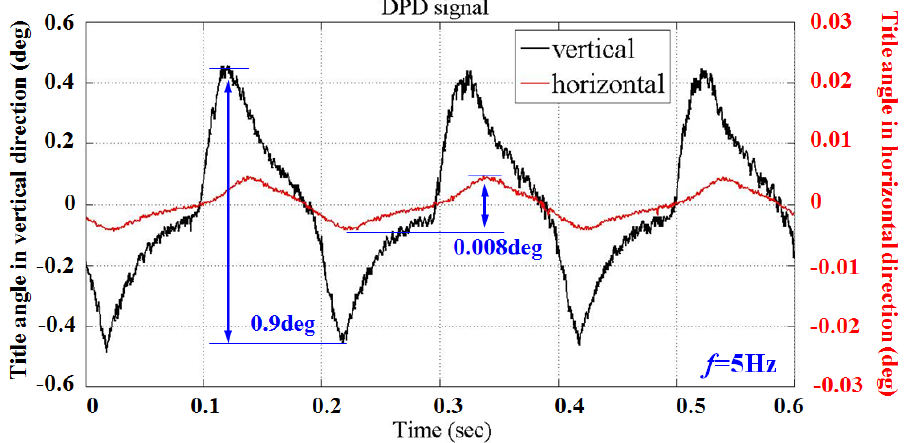
Figure 20. Comparison of two actuation directions with the DPD measurement results from the tilt error signal (black) and lateral deviation (red).